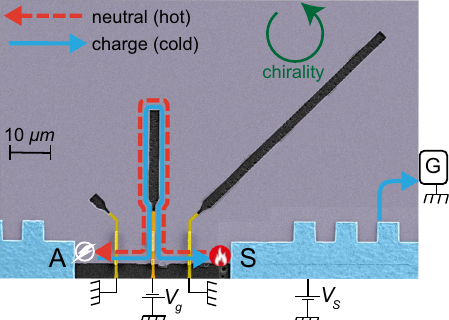
Fig. 1 Device. False colors SEM image of the heart of Device A. This device consists of three Ohmic contacts at the edge of the MESA (colored gray): Source (S), Ampli fi er (A) and the cold-grounded drain (G) (shown by symbol only). The propagation length of the edge modes between the S and A contacts can be tuned by using the three metallic gates (light-yellow: unbiased, dark-yellow: biased), which upon biasing, add the etched regions inside the MESA (funnel shaped black regions) to the upstream